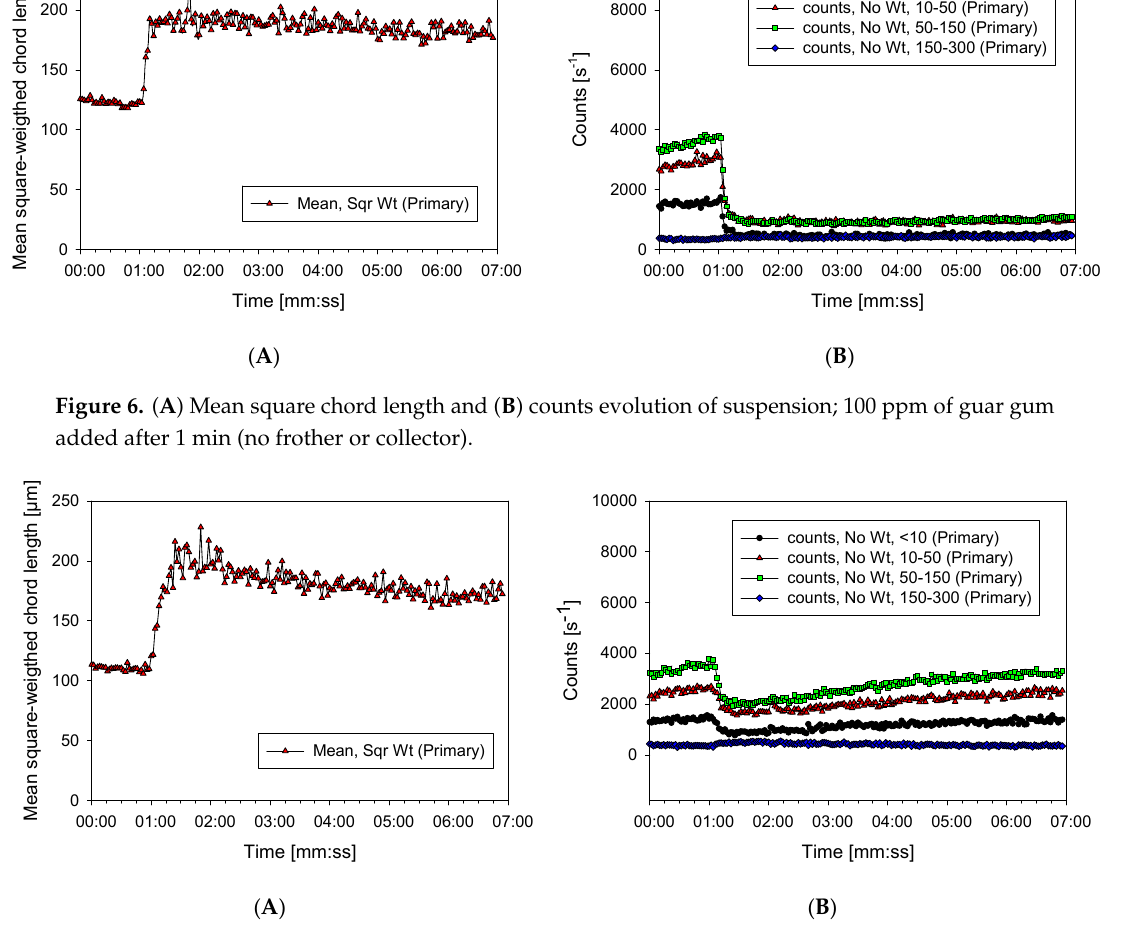
Figure 7. ( A ) Mean square chord length and ( B ) counts evolution of suspension; 200 ppm of guar gum added after 1 min (no frother or collector).